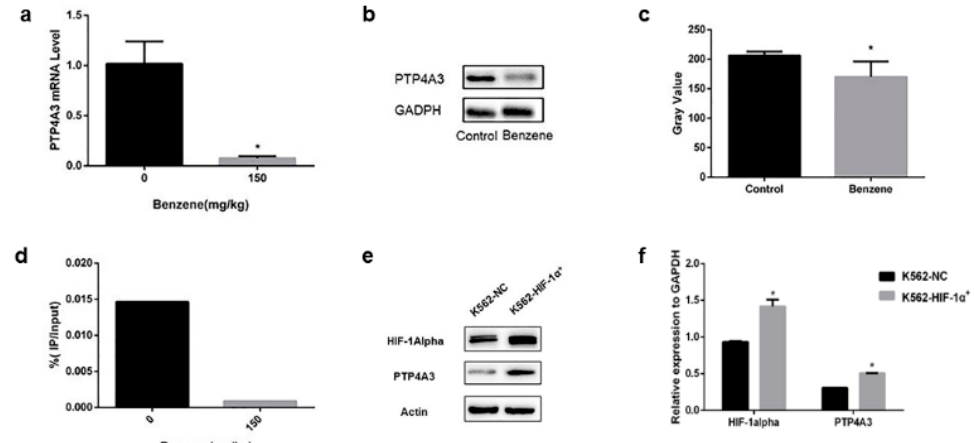
Figure 3. PTP4A3 participated in benzene toxicity under the regulation of HIF-1alpha. ( a ) The mRNA level of PTP4A3 was measured with real-time quantitative PCR. ( b , c ) The expression of PTP4A3 in benzene-exposed mice was measured with western blot. ( d ) The relationship between HIF-1alpha and PTP4A3 in benzene exposed mouse bone marrow was measured with ChIP-qPCR. ( e , f ) The expression of PTP4A3 was measured in HIF-1alpha high expression K562 cells (K562-HIF-1 α + ). The β -actin was applied to internal reference. *: p < 0.05, compared with the control group.